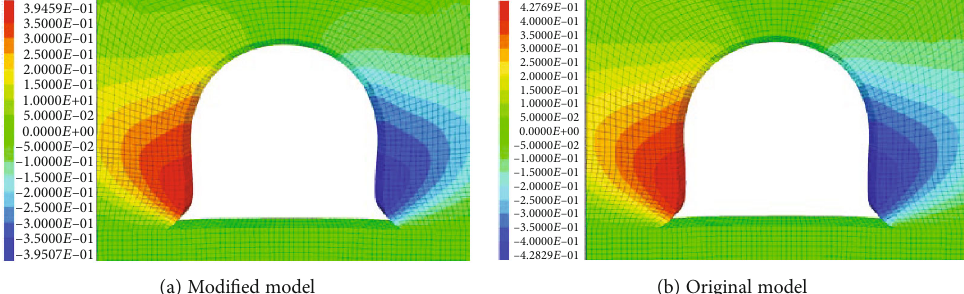
Figure 14: The horizontal displacement contour of the surrounding rock masses when the modi fi ed model and the original model arrive at the calculation